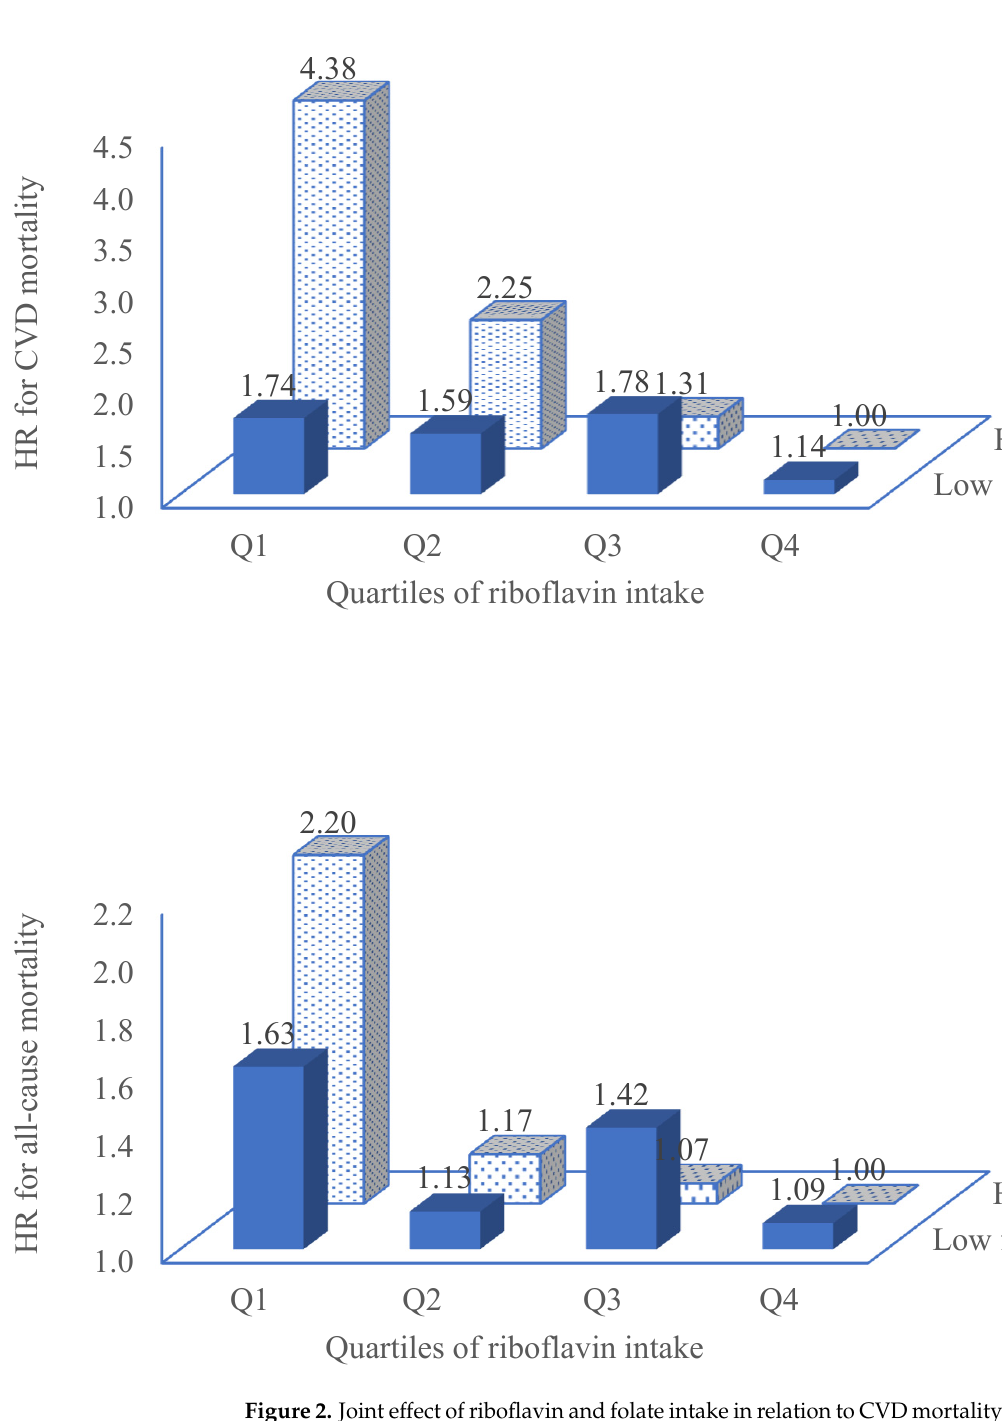
Figure 2. Joint effect of riboflavin and folate intake in relation to CVD mortality and all-cause mortality. Model adjusted for age, gender, race, physical activity, education, smoking, alcohol drinking, intake of energy and fat, metabolic syndrome, depression, and short sleep. Individuals with high intake of folate (quartile 3 and 4) and quartile 4 of riboflavin were used as the reference group. The number of individuals in each group was as follows: high folate (Q1–Q4 of riboflavin, 295, 997, 1703, 2245); low folate (2327, 1622, 916, 375).